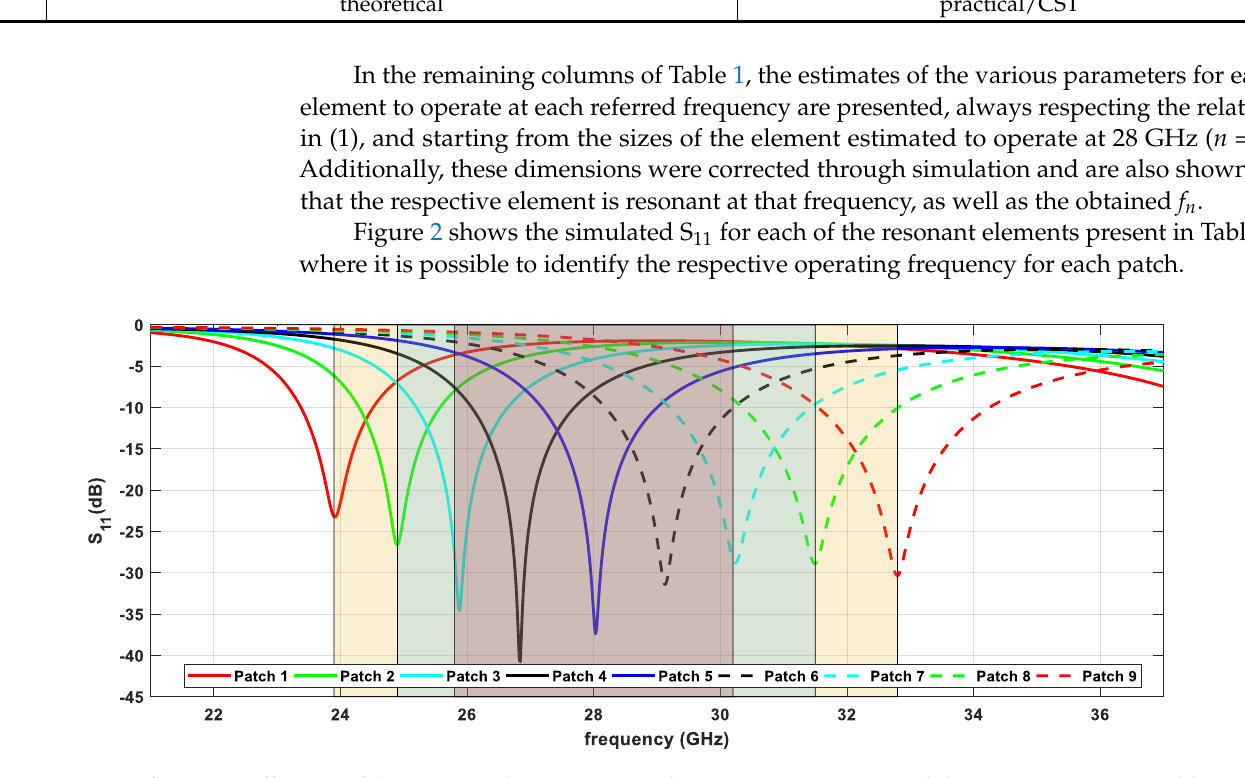
Figure 2. Reflection coefficients of the optimized microstrip patch antennas using practical design parameters in Table 1, and frequency zones defined by 5, 7, and 9 elements.